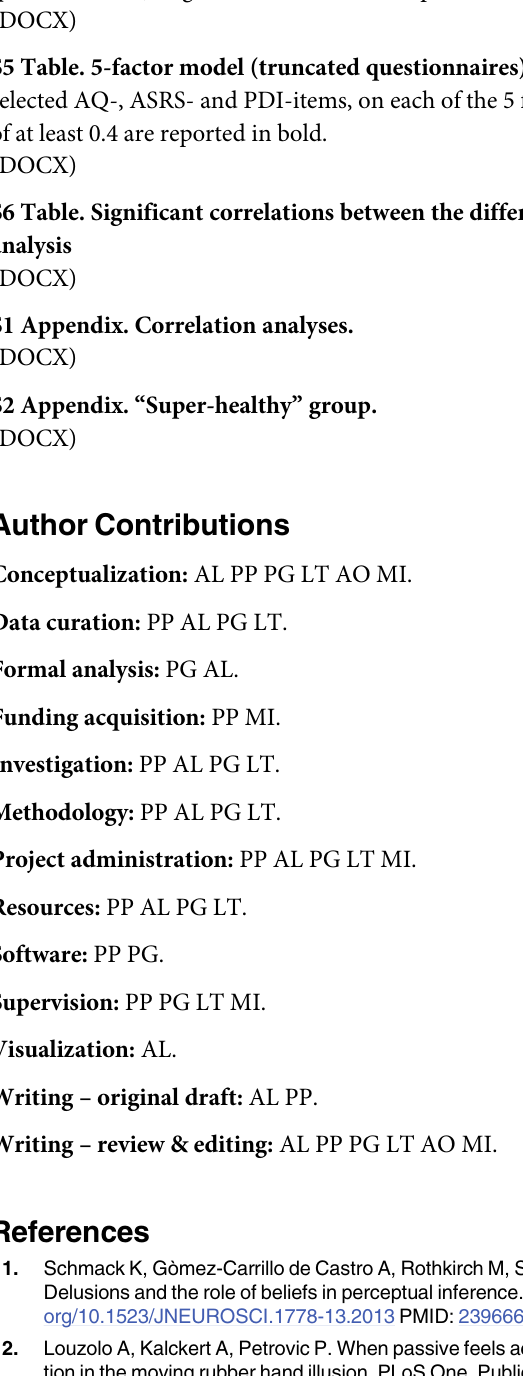
S3 Table. 7-factor model (full questionnaires). Standardised loadings of all AQ-, ASRS- and PDI-items, on each of the 7 factors. Items with standardised loadings of at least 0.4 are reported in bold. S4 Table. Correlations between the different factors from the 7-factor model analysis (full questionnaires). Significant correlations reported in bold S5 Table. 5-factor model (truncated questionnaires). Standardised loadings of all the selected AQ-, ASRS- and PDI-items, on each of the 5 factors. Items with standardised loadings of at least 0.4 are reported in bold. S6 Table. Significant correlations between the different factors from the 5-factor model